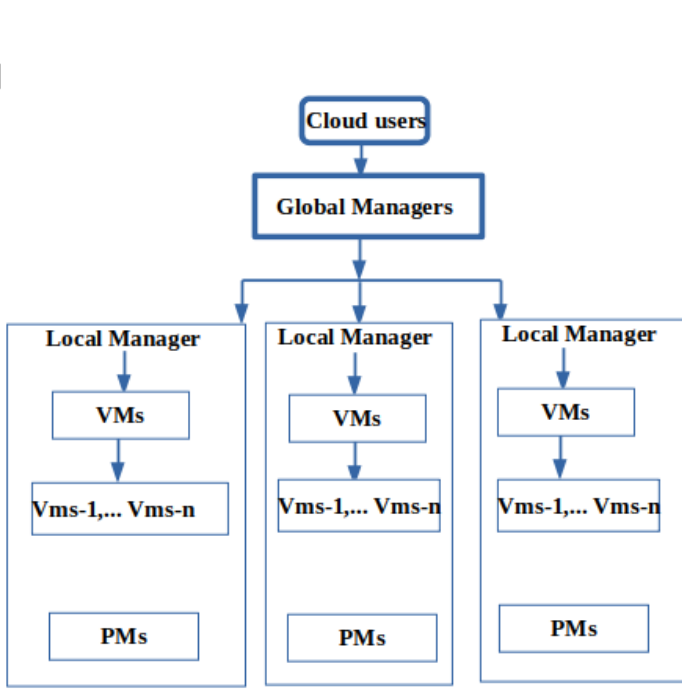
Fig. 1. System model for proposed